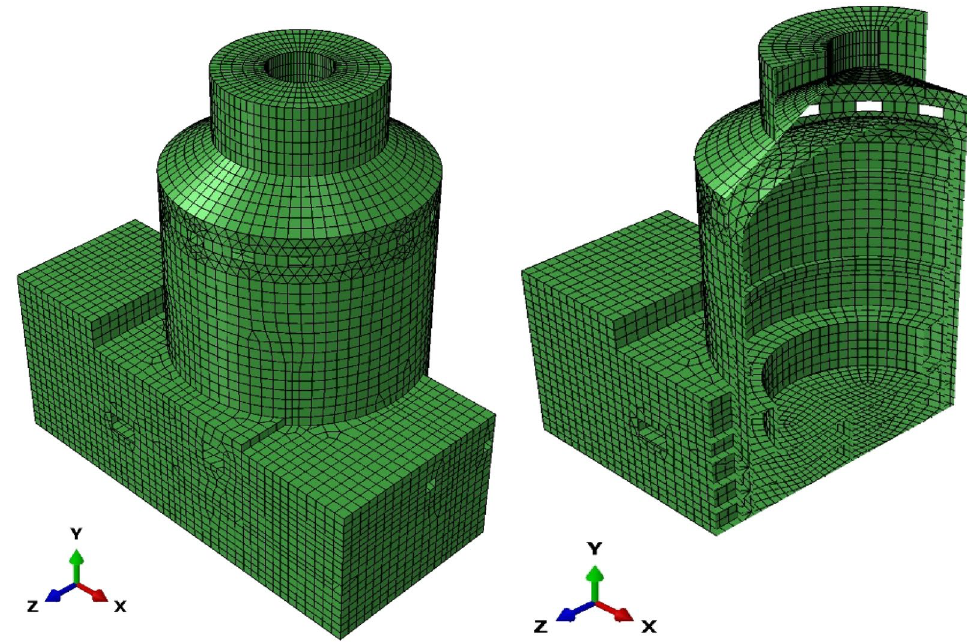
Figure 21. FEM model of the NPP structure.